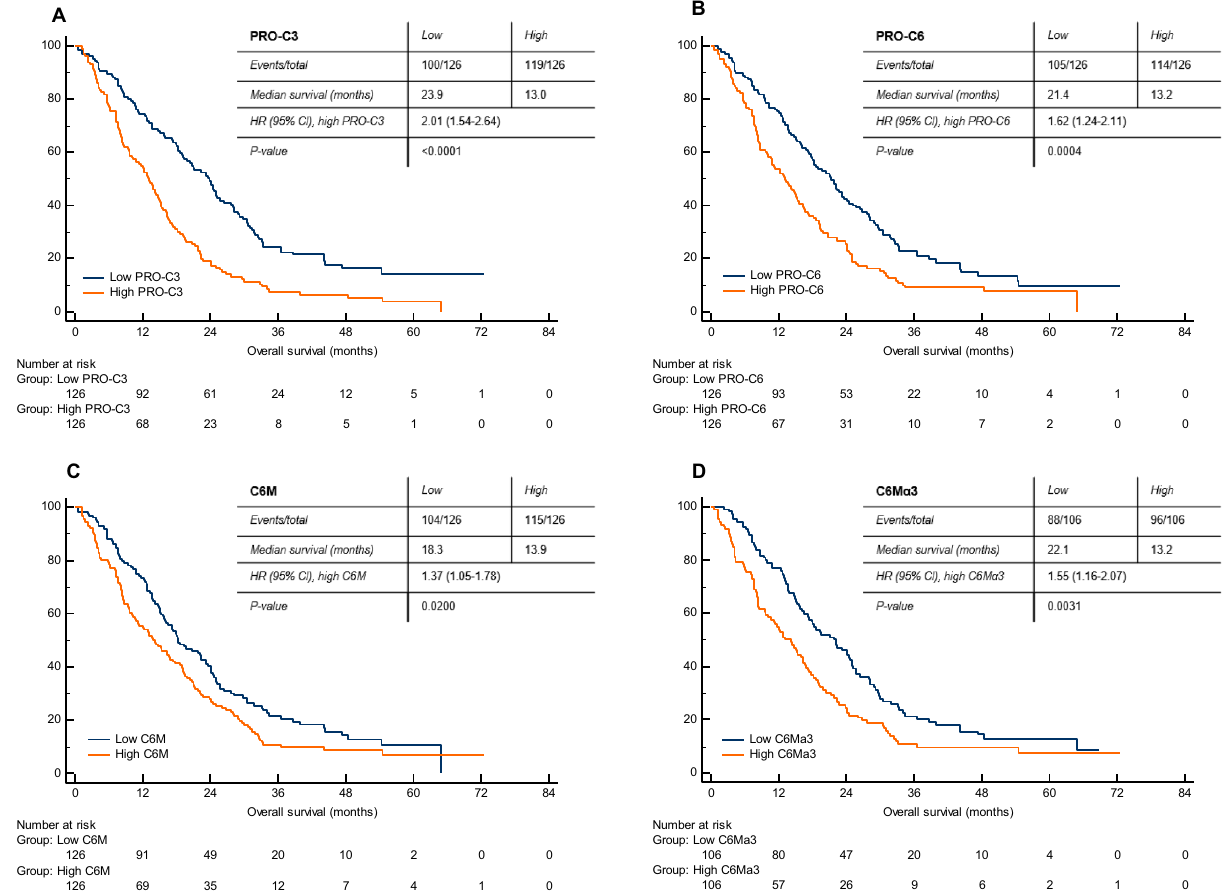
Figure 3. Assessment of the prognostic potential of low and high (median) ( A ) PRO-C3 (formation of collagen type III), ( B ) PRO-C6 (formation of collagen type VI), ( C ) C6M (degradation of collagen type VIα1) and ( D ) C6Mα3 (degradation of collagen type VIα3) serum levels by Kaplan Meier plots. Cox proportional-hazards regression was used to calculate the hazard ratios (HR) with 95% Cl and p -values. A p < 0.05 was considered